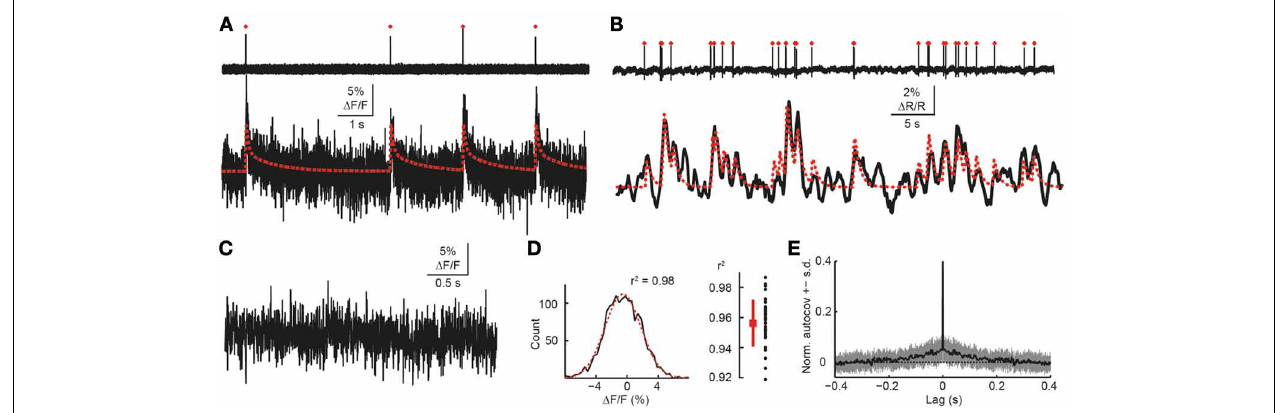
FIGURE 9 | Validation of simulation framework with experimental data. (A) Simultaneous cell-attached recording and high-speed two-photon calcium imaging in mouse neocortex in vivo . Top trace: cell-attached recording, APs marked by red dots. Bottom trace: measured cellular (cid:2) F / F calcium signal (black) as well as simulated (cid:2) F / F traces (red) for the recorded spike train. Imaging data were acquired with OGB-1 at 490Hz sampling rate (Grewe et al., 2010). Note that a non-saturating model with double-exponential decay was used in this case to generate the simulated trace. (B) Simultaneous cell-attached recording and two-photon calcium imaging using the genetically-encoded calcium indicator YC3.60 (Lütcke et al., 2010). Top trace: cell-attached recording, APs marked by red dots.